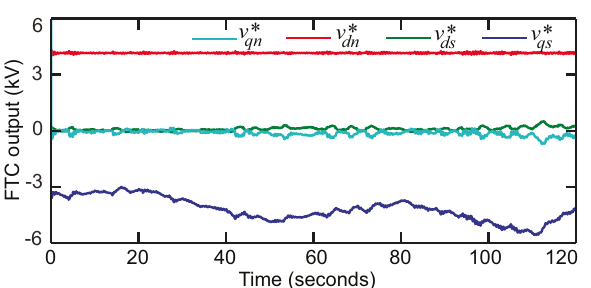
Figure 8. Reference control outputs of the MSC and the GSC by the FTC.